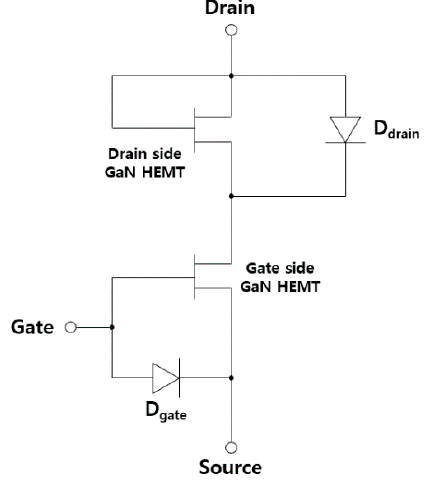
Figure 4. Equivalent circuit of unidirectional HFET.